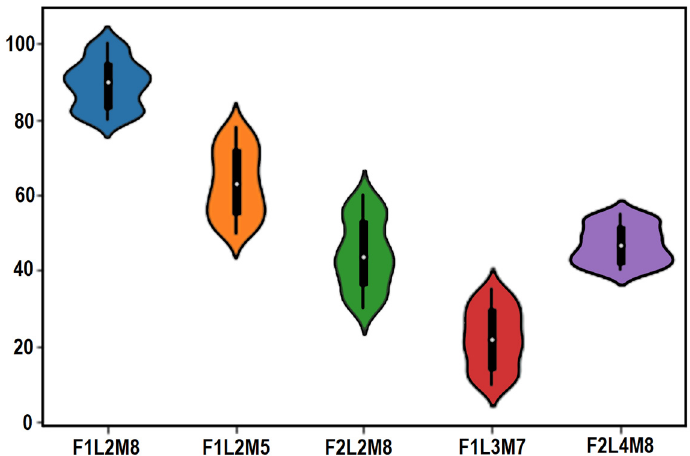
Figure 4. Human observer evaluation score on Multiple Hyperparameter.